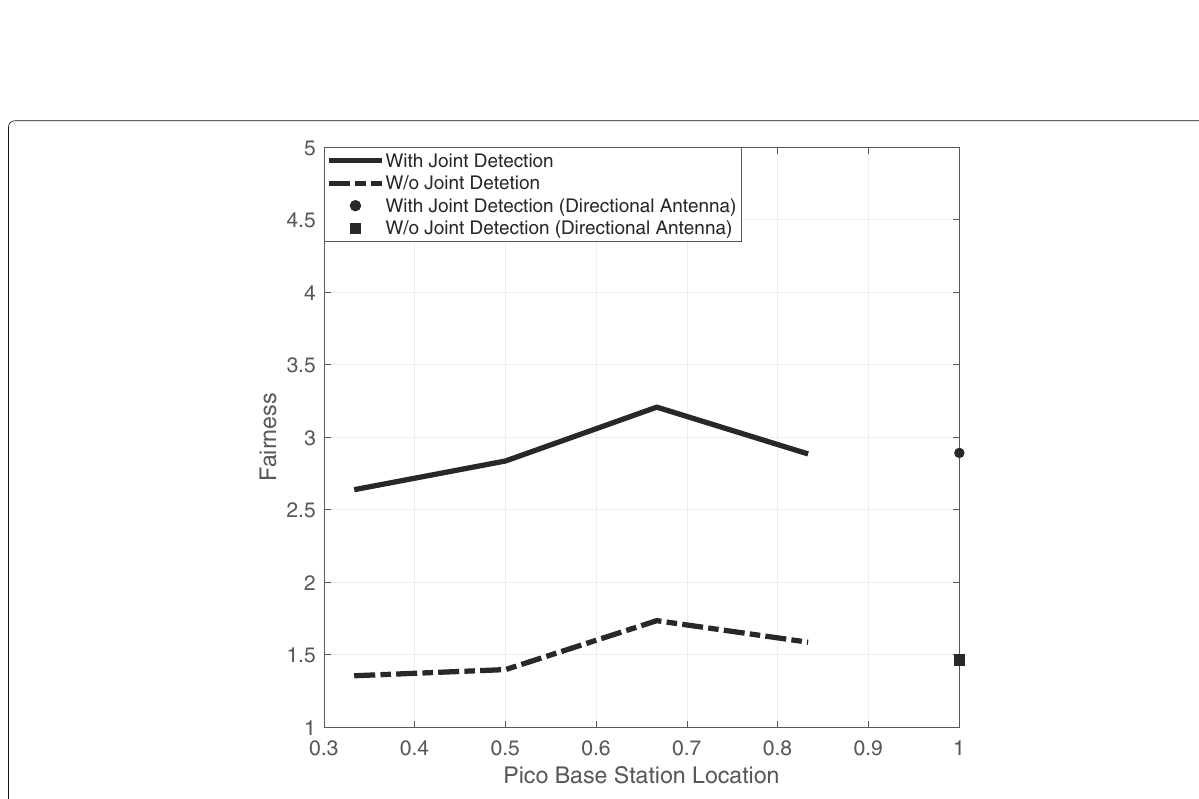
Fig. 10 User fairness versus PBS location (5